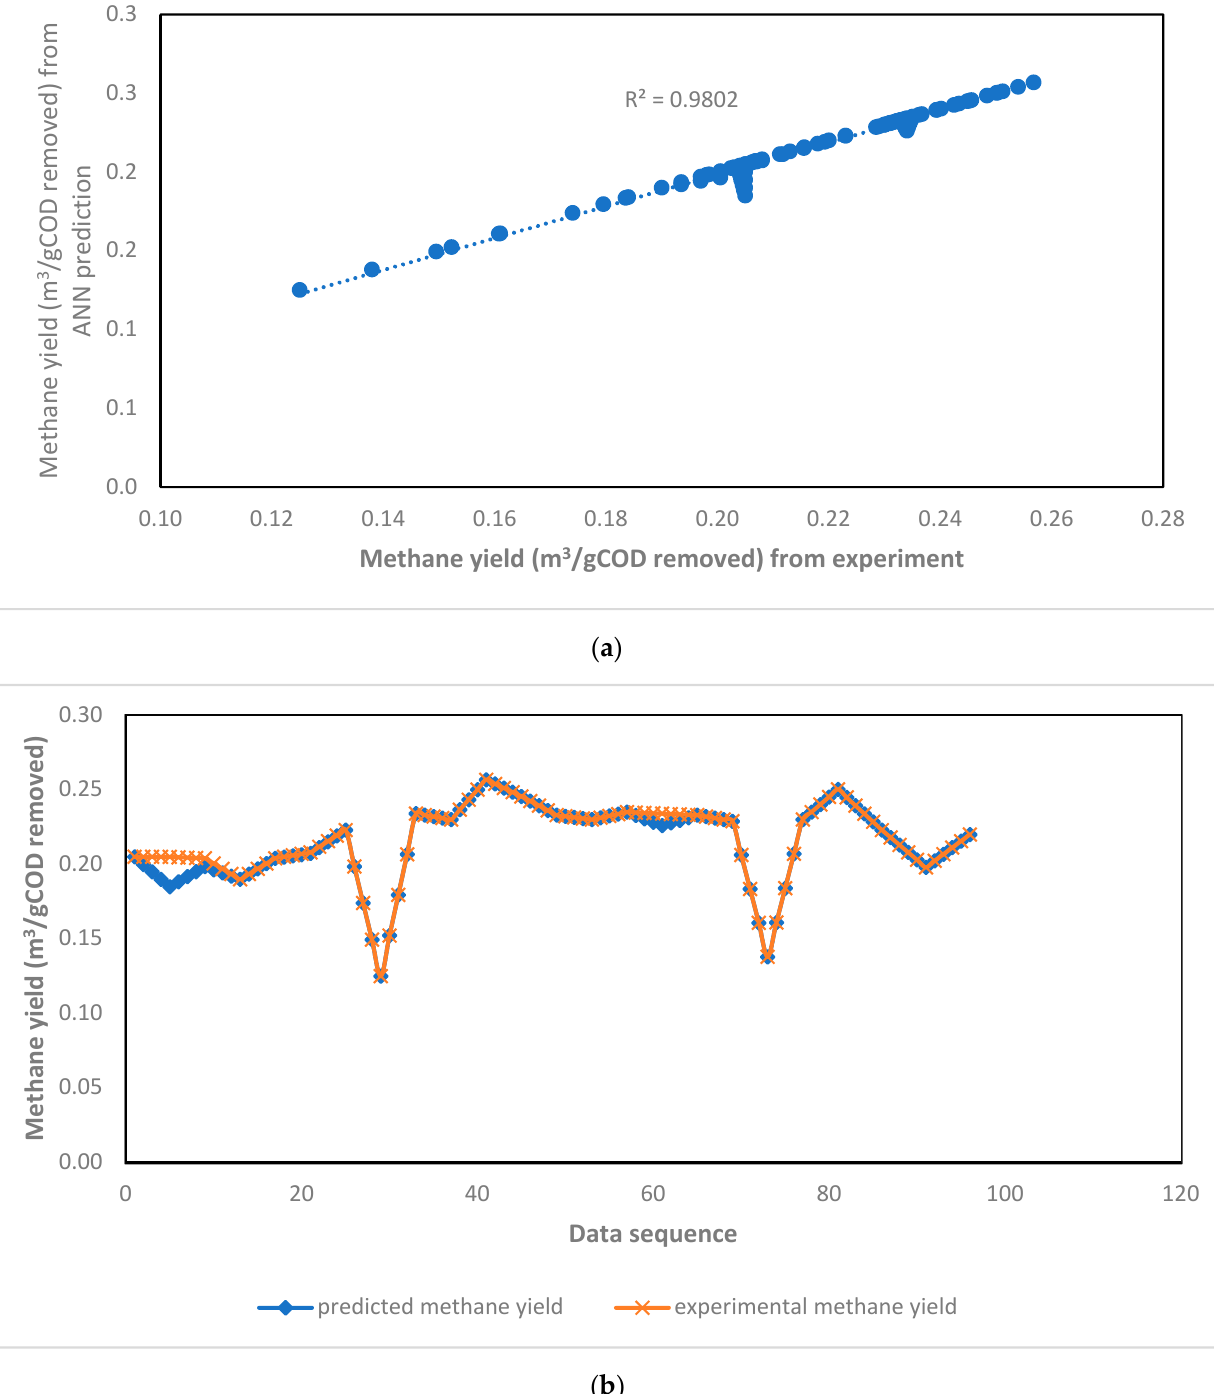
Figure 5. ( a ) Correlation between experimental data and predicted value of methane yield, ( b ) Prediction value and measured data by ANN model for methane yield (anaerobic digestion).